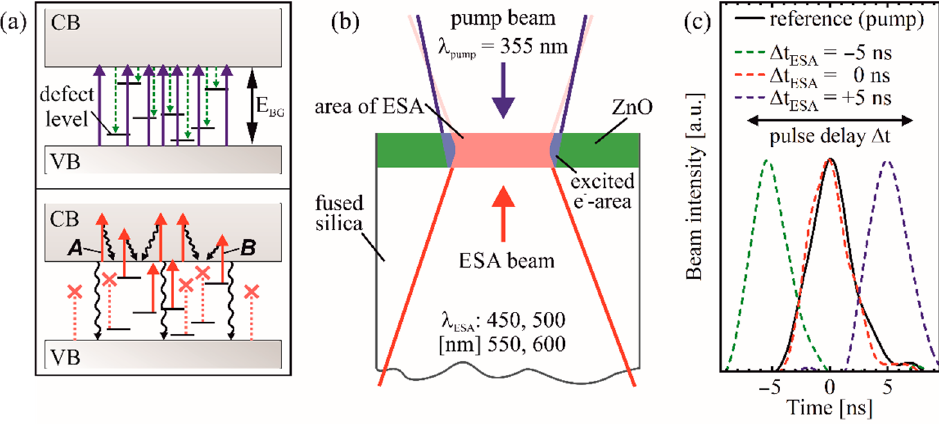
Figure 1. ( a ) Schematic illustration of the theoretical excited state absorption (ESA)-based ablation process with excitation (top) and a subsequent ESA (bottom), indicated by solid arrows. The electrons, excited prior by the pump beam with E P > E BG , rapidly relax radiative or non-radiative (dashed arrows) and partially migrate to defect levels located within the band gap. The subsequent ESA beams with E P < E BG are absorbed by either intra-band A or defect level → conduction band (CB) B transitions, both enabled only by the prior pump excitation. Waved and dashed arrows indicate non-radiative and forbidden transitions, respectively. ( b ) Sample cross section of 1 mm thick fused silica substrate coated with a 200 nm thin ZnO layer. The beam directions are indicated by arrows. ( c ) Illustration of selected pulse delays ∆ t = − 5, 0, +5 ns (dashed lines) and their temporal overlap with the pump pulse (solid line).